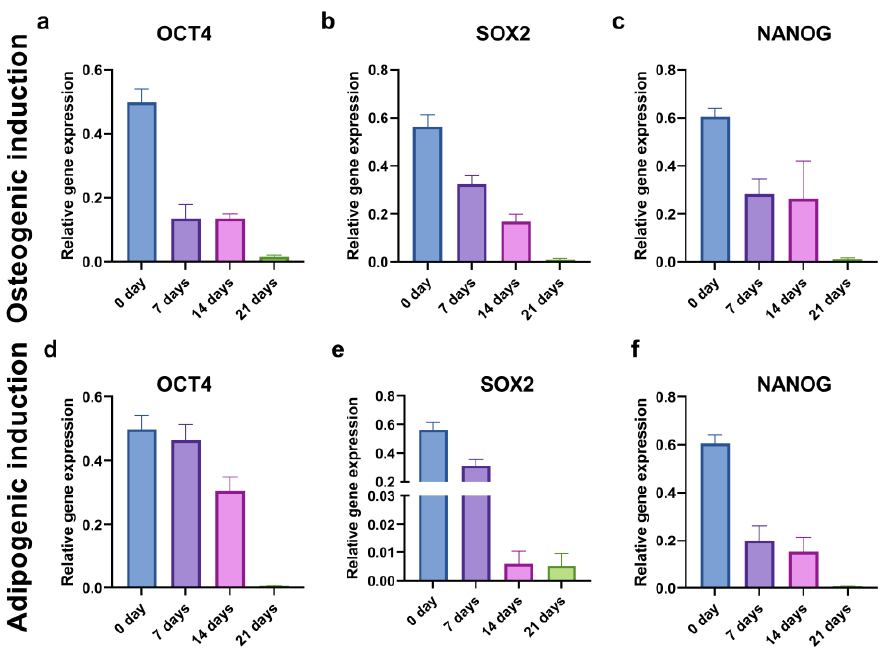
Figure 11. Relative gene expression levels of stemness markers OCT4 ( a , d ), SOX2 ( b , e ), and NANOG ( c , f ) in CD44 + cells during 21 days of osteo-induction ( a – c ) and adipo-induction ( d – f ).